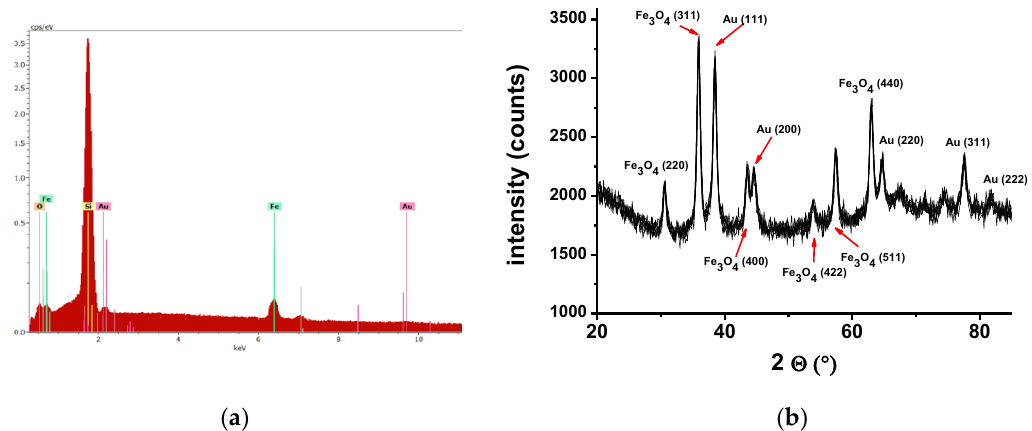
Figure 1. ( a ) EDX analysis of Fe 3 O 4 @Au pNPs; ( b ) XRD pattern of Fe 3 O 4 @Au pNPs.